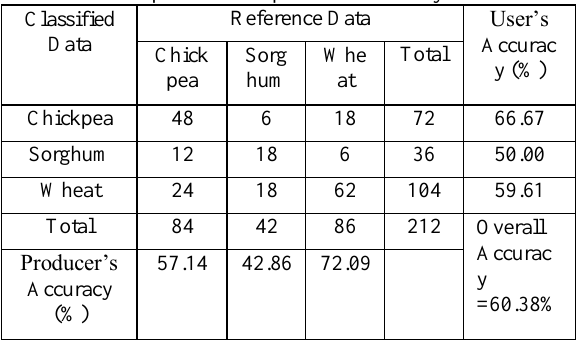
Table 9: Error matrix for the image classified using field spectra developed conventionally Classified